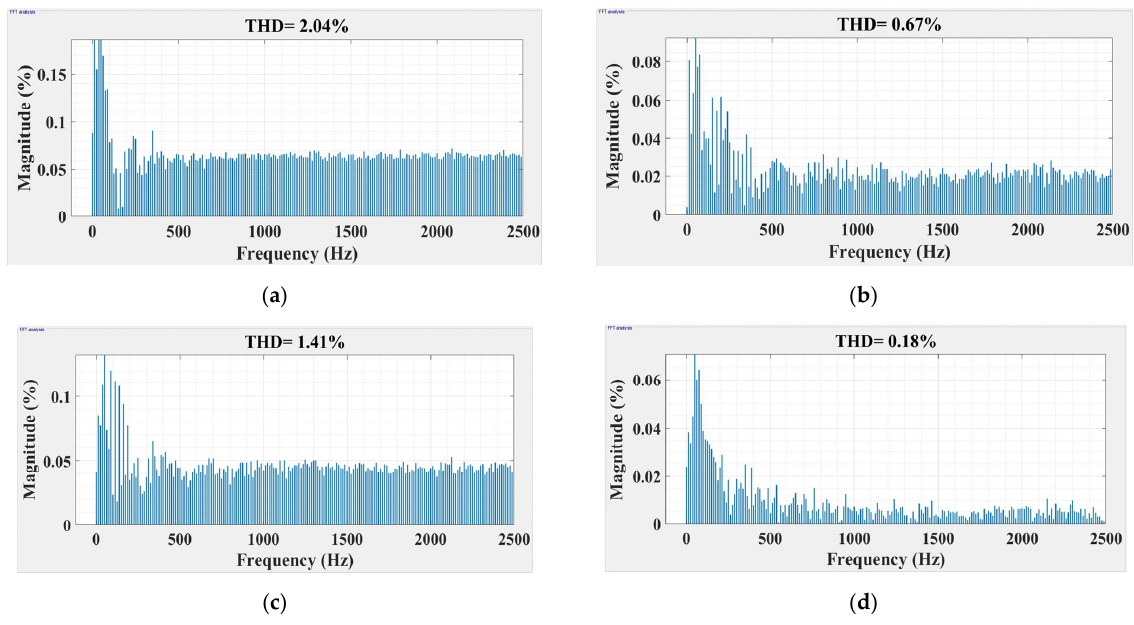
Figure 17. FFT analysis and THD voltage calculus for APF control: ( a ) PI controller and nonlinear load; ( b ) PI controller and linear load; ( c ) PI controller with RL-TD3 agent and nonlinear load; ( d ) PI controller with RL-TD3 agent and linear load.